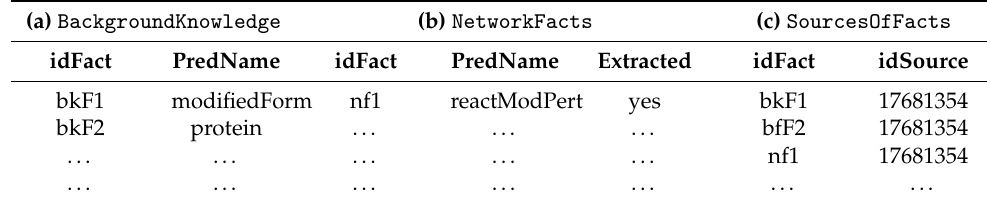
Table 9. Tables relative to